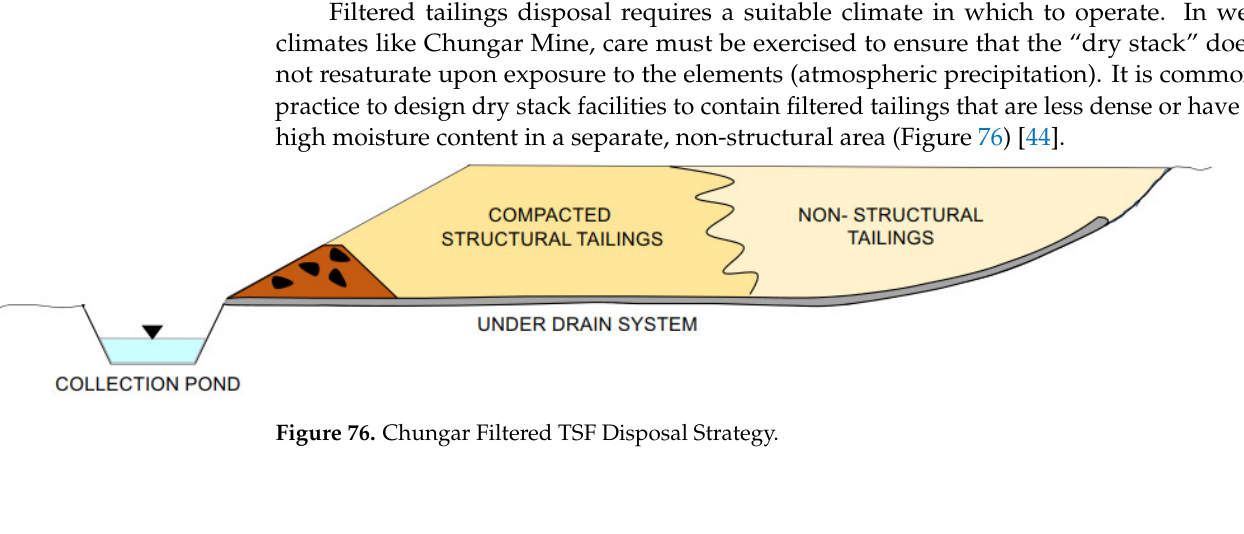
Figure 76. Chungar Filtered TSF Disposal Strategy.